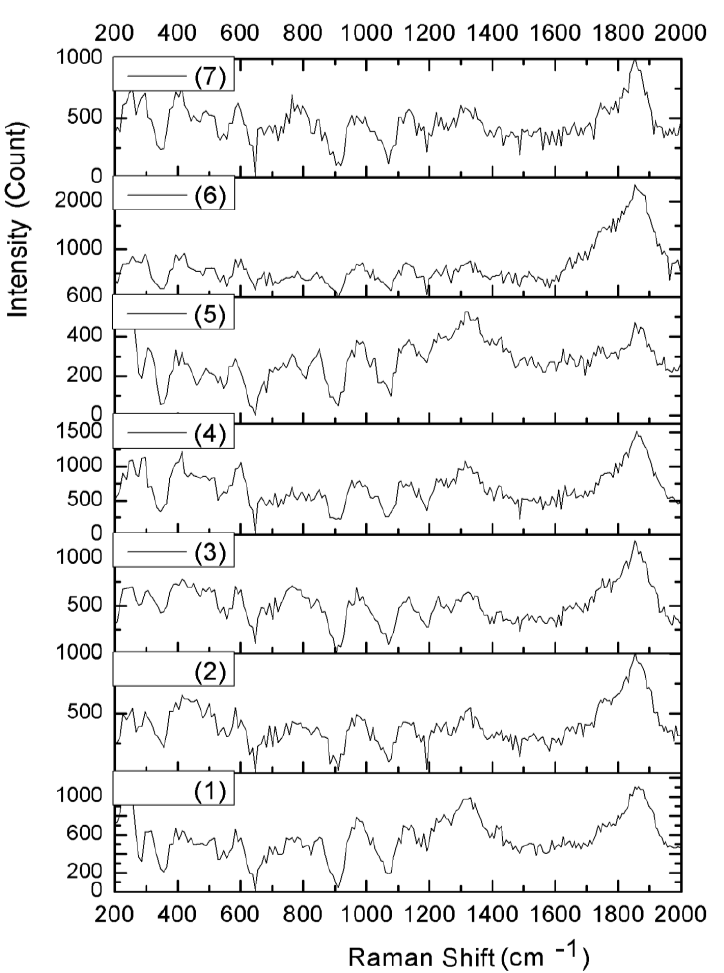
Figure 11. Raman spectra for the investigated samples. The explanation of (1) – (7) is the same with the codification from Table 1.